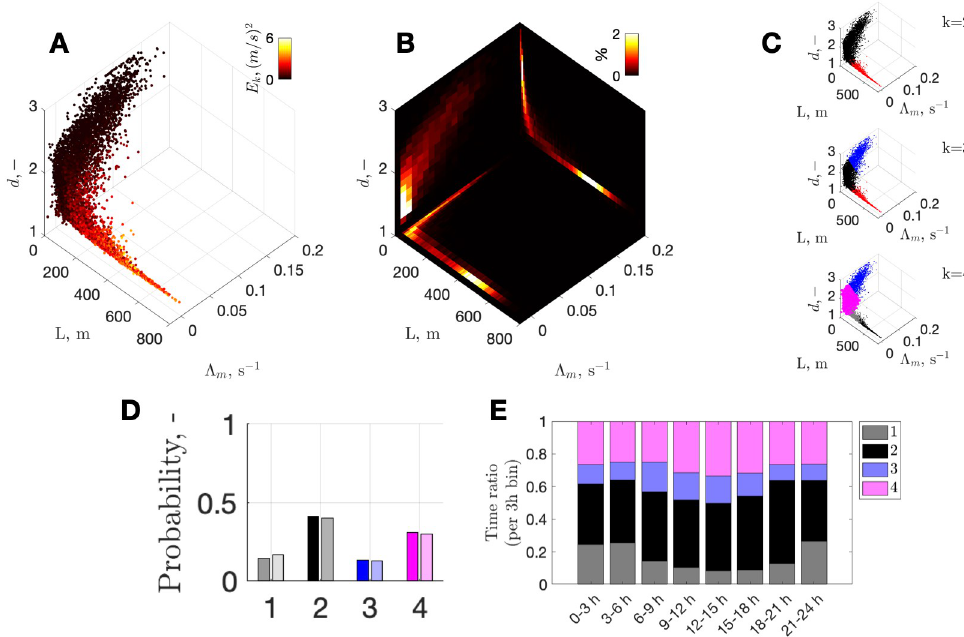
Fig 3. From attractor properties to time-budgets and day partition. (A) Overall parameter space of chaotic measures: Euclidian distances ( L ), maximum Lyapunov exponents ( Λ ), and attractor dimension ( d ) (color represents kinetic m energy, E k ). (B) Example of corresponding density maps for each plane; colormap shows the number of points (%) within each bin (mesh: dx 10 m by dy 0.01 s − 1 by dz 0.1). (C) De-clustered parameter space, using non-supervised classification based on Gaussian mixture models with 2, 3, and 4 components ( k ), revealing at least 2 distinct regions separated at L � 100 m. (D) Relative time budgets for each cluster. Points with the highest membership scores ( > 0.9) are shown in solid color (i.e., highest confidence); full clustering results (with possible ambiguity) are shown with faint color but are similar to high-score-only bins. (E) Partition of time between all clusters for each 3 h bin (full clustering results).